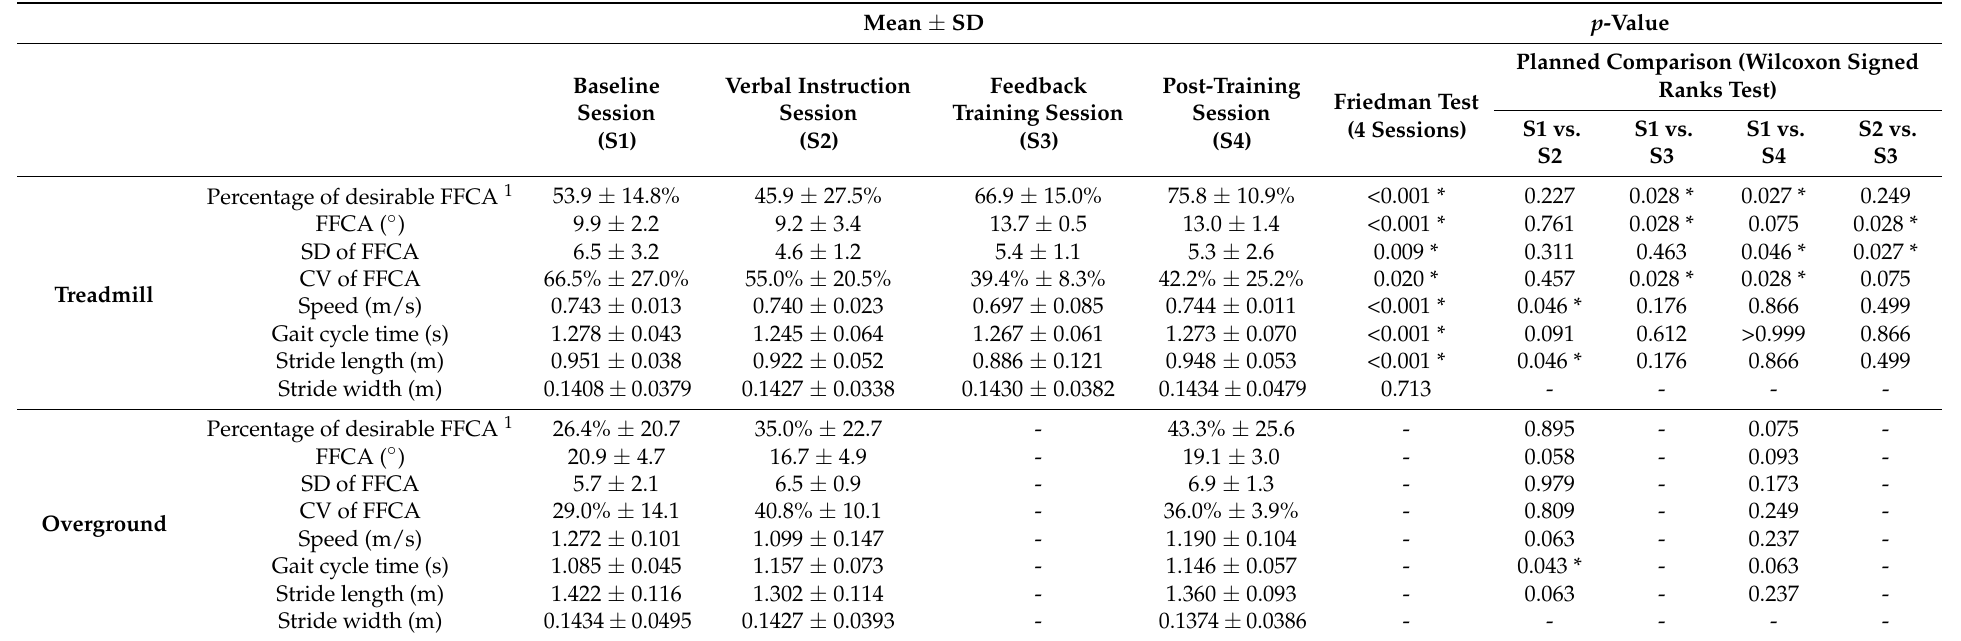
Table 1. Comparison of the FFCA across all sessions ( n =